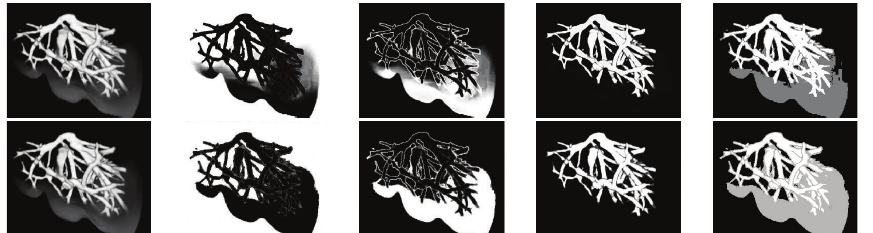
Figure 4: MRI liver segmentation. The first line: segmentation using Shen’s model. The second line: segmentation using the proposed model. From left to right: original image, three membership functions, and hard segmentations,